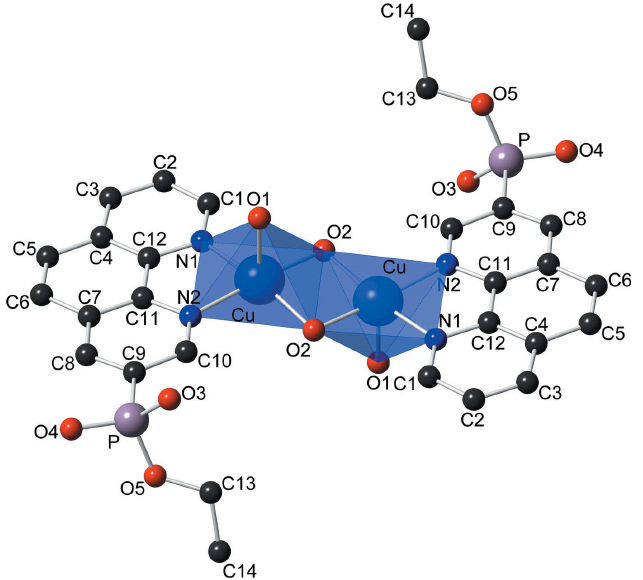
Figure 2 View of the title compound showing the coordination polyhedra around the copper atoms in the dimer. Only the highest occupancy components of the disordered ethyl groups (C13 and C14) are shown.